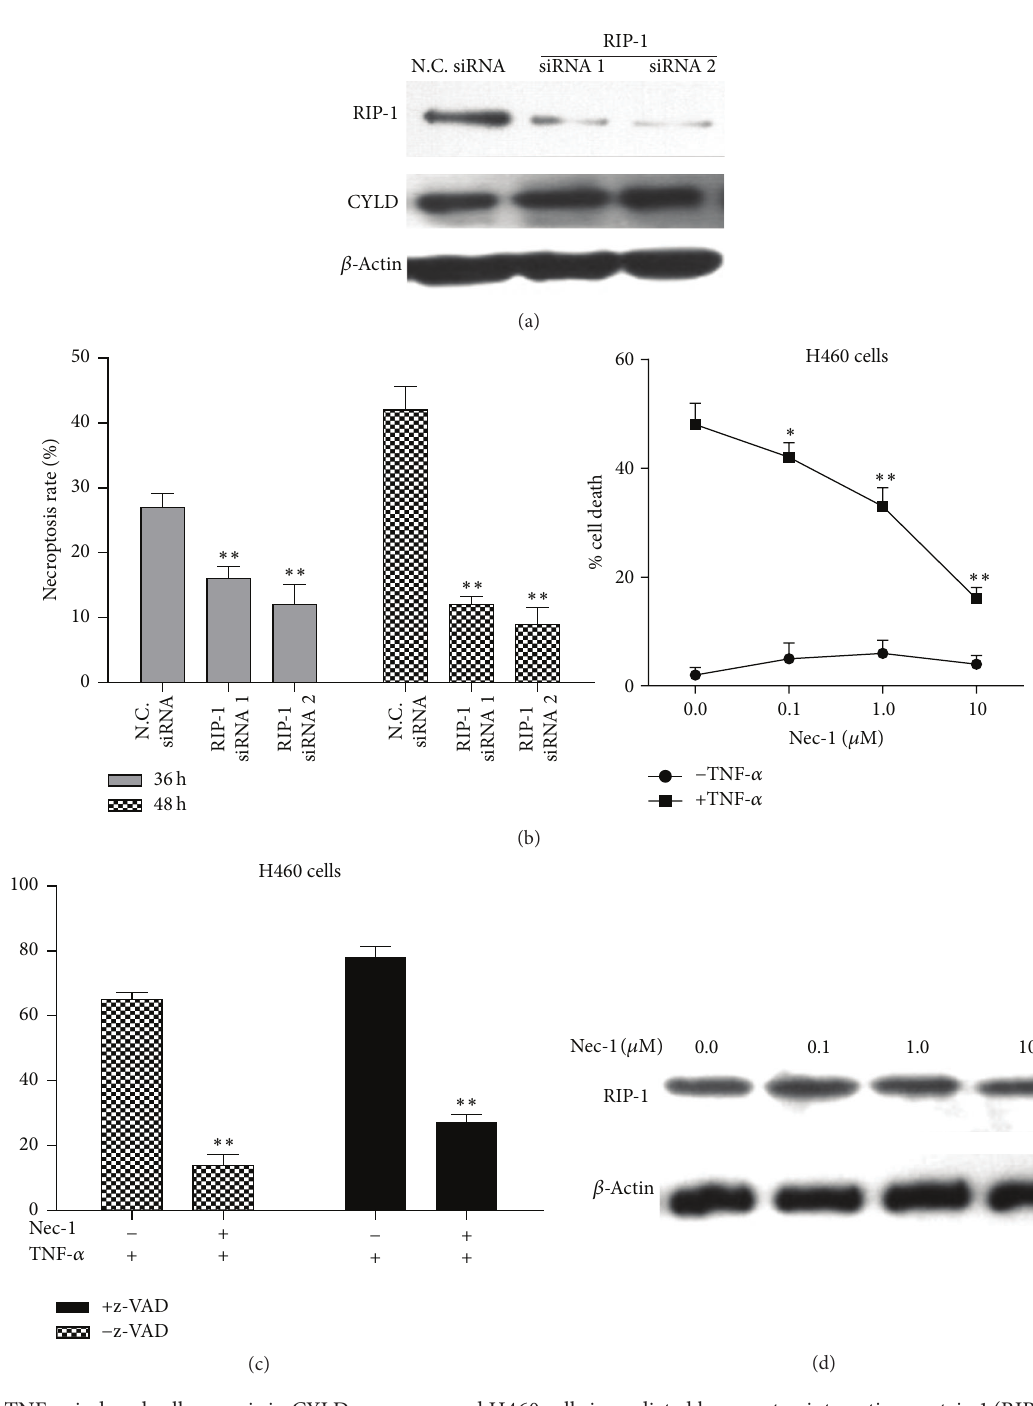
Figure 6: TNF- 𝛼 -induced cell necrosis in CYLD-overexpressed H460 cells is mediated by receptor-interacting protein 1 (RIP-1) kinase. (a) The stable cell line of CYLD-flag transfected H460 cells was plated into 6-well plate. The cells were cultured for 6 hours and transfected with two pairs of siRNA specific to RIP-1 for 48 hours. The levels of endogenous RIP-1 and CYLD were detected by western blotting analysis. 𝛽 -Actin was used as internal reference gene in the present experiment. (b) The CYLD-overexpressed H460 cells were transfected with siRNA specific to RIP1 for 36 h and 48 h. The necrosis rate (PI-positive rate) was determined by FACS analysis. ∗∗ 𝑝 < 0.01 , compared with the cells transfected with N.C. siRNA. (c) The H460 cells were plated into 12-well plate and treated with 100ng/mL of TNF- 𝛼 in combination with or without 10 𝜇 M of z-VAD-fmk for 24 hours. Then, the cells were collected and PI-positive cell rate was determined as described in Material and Method. ∗∗ 𝑝 < 0.01 , compared with the group without z-VAD. (d) The CYLD-overexpressed H460 cells were plated into 6-well plate and treated with 100 ng/mL of TNF- 𝛼 in combination with increasing concentrations of Nec-1 for 24 hours. The concentrations of Nec-1 were 0 𝜇 M, 0.1 𝜇 M, 1.0 𝜇 M, and 10 𝜇 M, respectively. The expression levels of RIP-1 were determined by western blotting